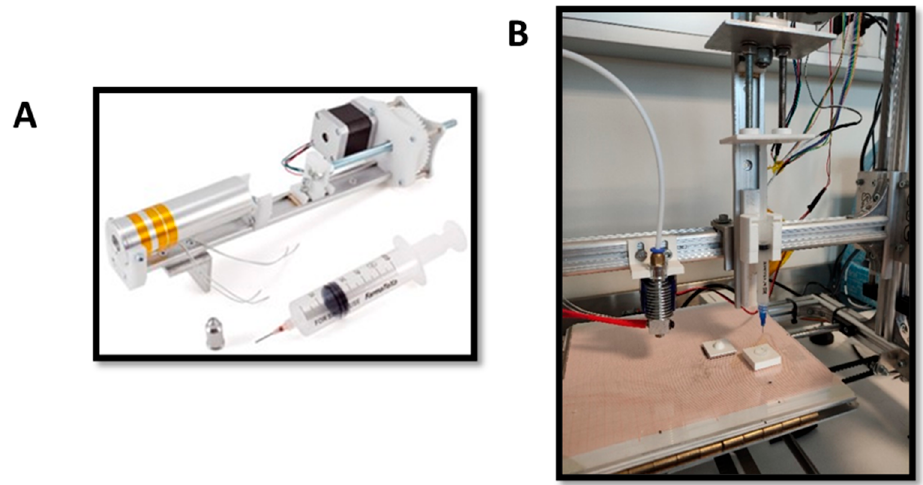
Figure 3. ( A ) The original extruder and ( B ) the modified version (RIGHT), assembled on the extruder beam of the 3DRAG next to the polymer extruder (LEFT).